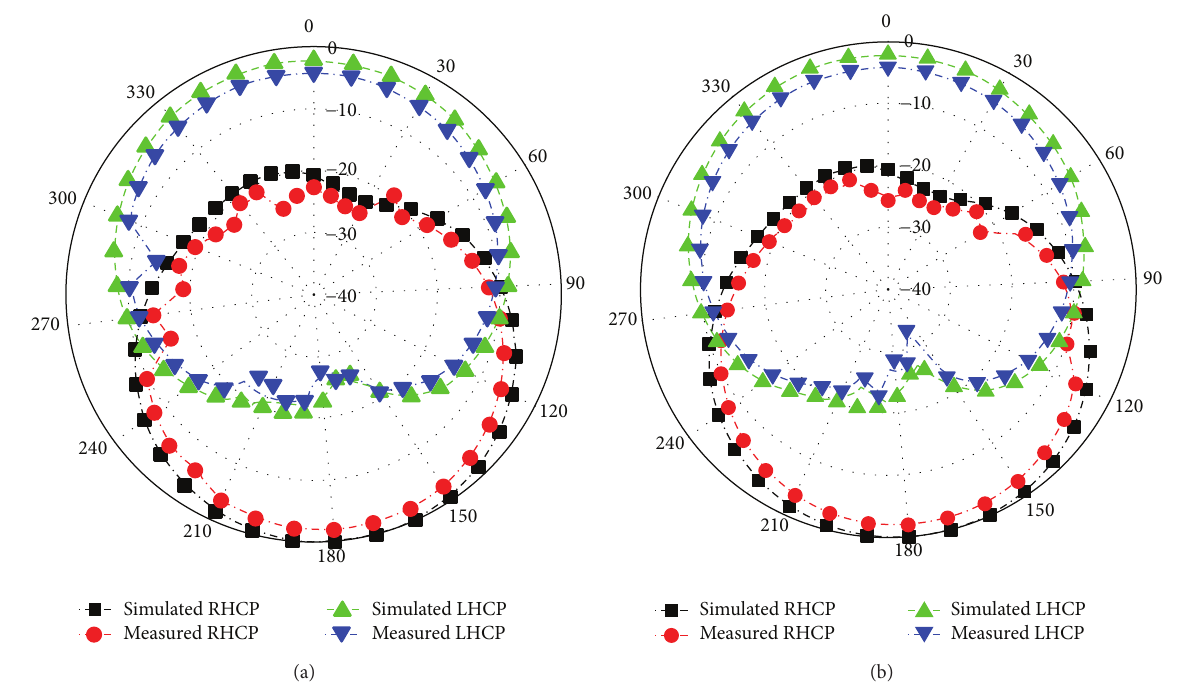
Figure 12: Measured and simulated radiation patterns at (a) 2.18GHz and (b) 3.30 GHz.